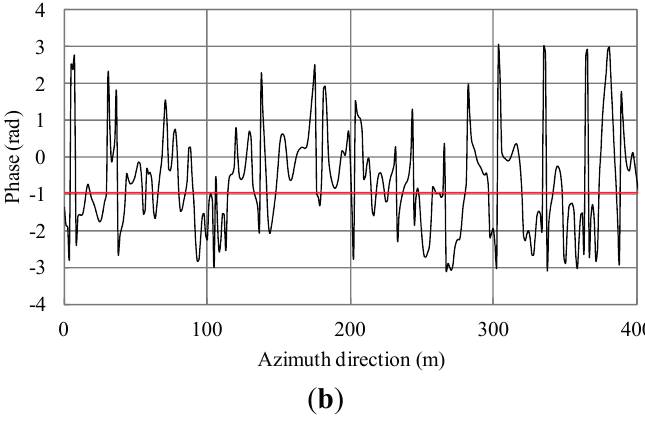
Figure 11. Simulation results of irregular waves for wind speed 15 m/s. ( a ) Phase of simulated SAR signals of master and slave antennas in the azimuth direction. ( b ) Phase differences of (a). The black line shows the phase differences. The red line shows the average.